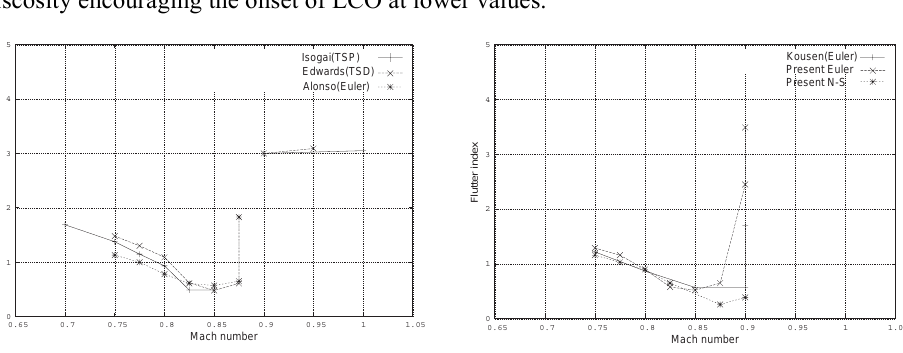
Fig. 7 Comparison of flutter boundaries for test case II (NACA